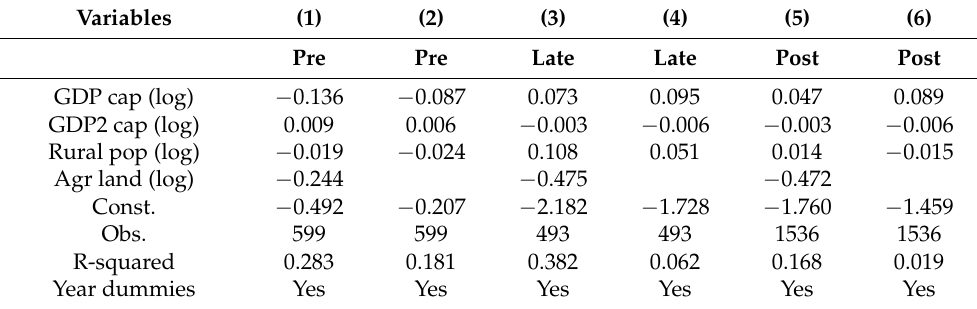
Table 6. Long-run equations, forest transition clusters.